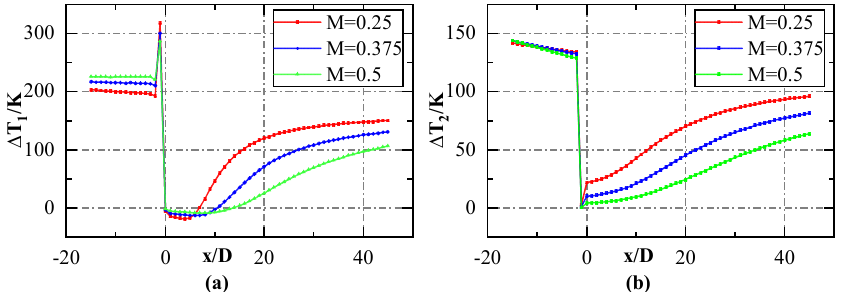
(cid:0) (cid:1) m 2 · K , γ =